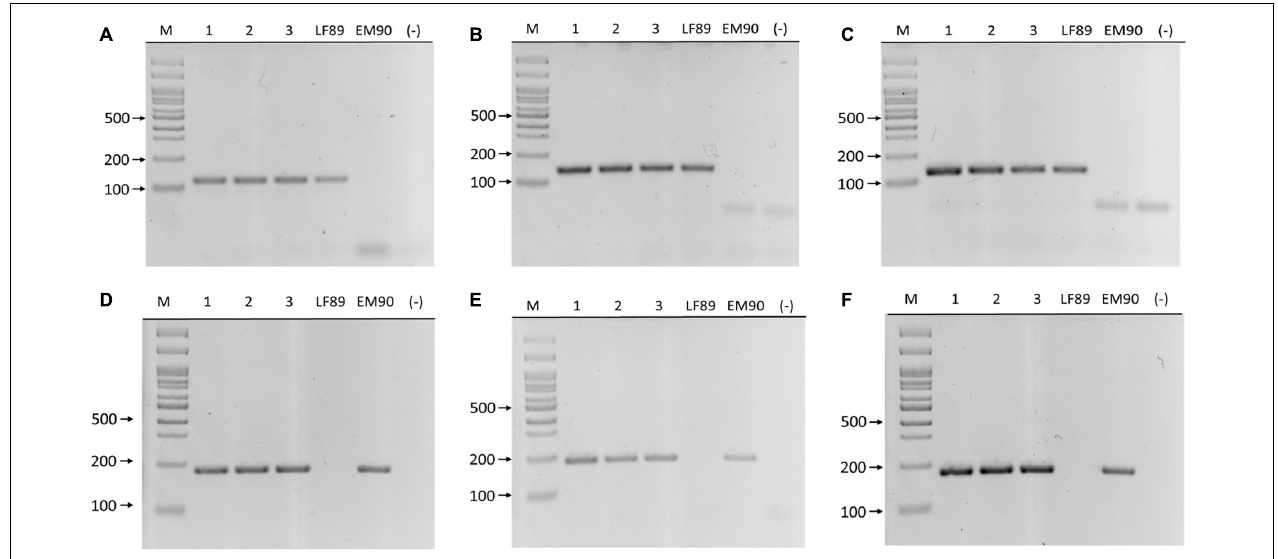
FIGURE 3 | PCR amplification of LF-89 and EM-90 unique genes in P. salmonis . Upper panels (A–C) primer pairs 660, 1755, and 2701, respectively. Samples (1) AUS005, (2) AUS008, (3) AUS025, LF-89 strain, EM-90 like strain, and (–) negative control. Bottom panels (D–F) primer pairs 1207, 371, and 2825, respectively.